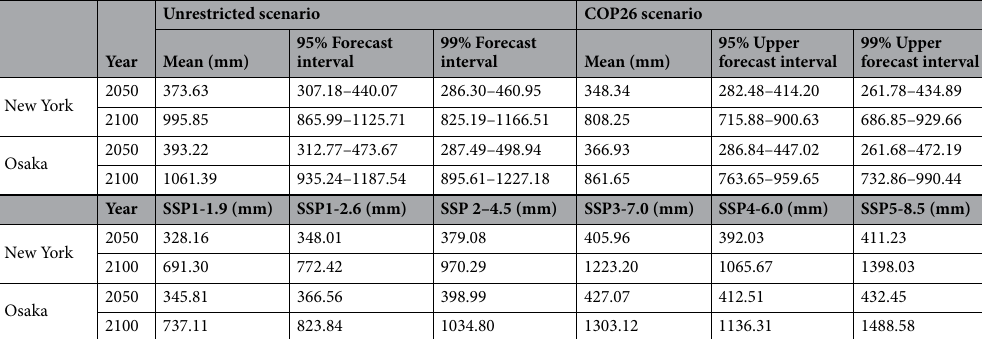
Table 2. Predicted mean and forecast interval (95% and 99%) for the regional mean sea level (RMSL) rise at New York City and Osaka by 2050 and 2100 respectively under unrestricted or COP26 restrictions on greenhouse gas emissions; and the predicted means of the regional mean sea level (RMSL) rise at New York City and Osaka by 2050 and 2100 under SSP1-1.9, SSP1-2.6, SSP2-4.5, SSP3-7.0, SSP4-6.0 and SSP5-8.5 scenarios. The RMSL baselines for New York City and Osaka are the respective mean values of the 20-year RMSL for the two regions from 1986 to 2005. The units of RMSL are mm.